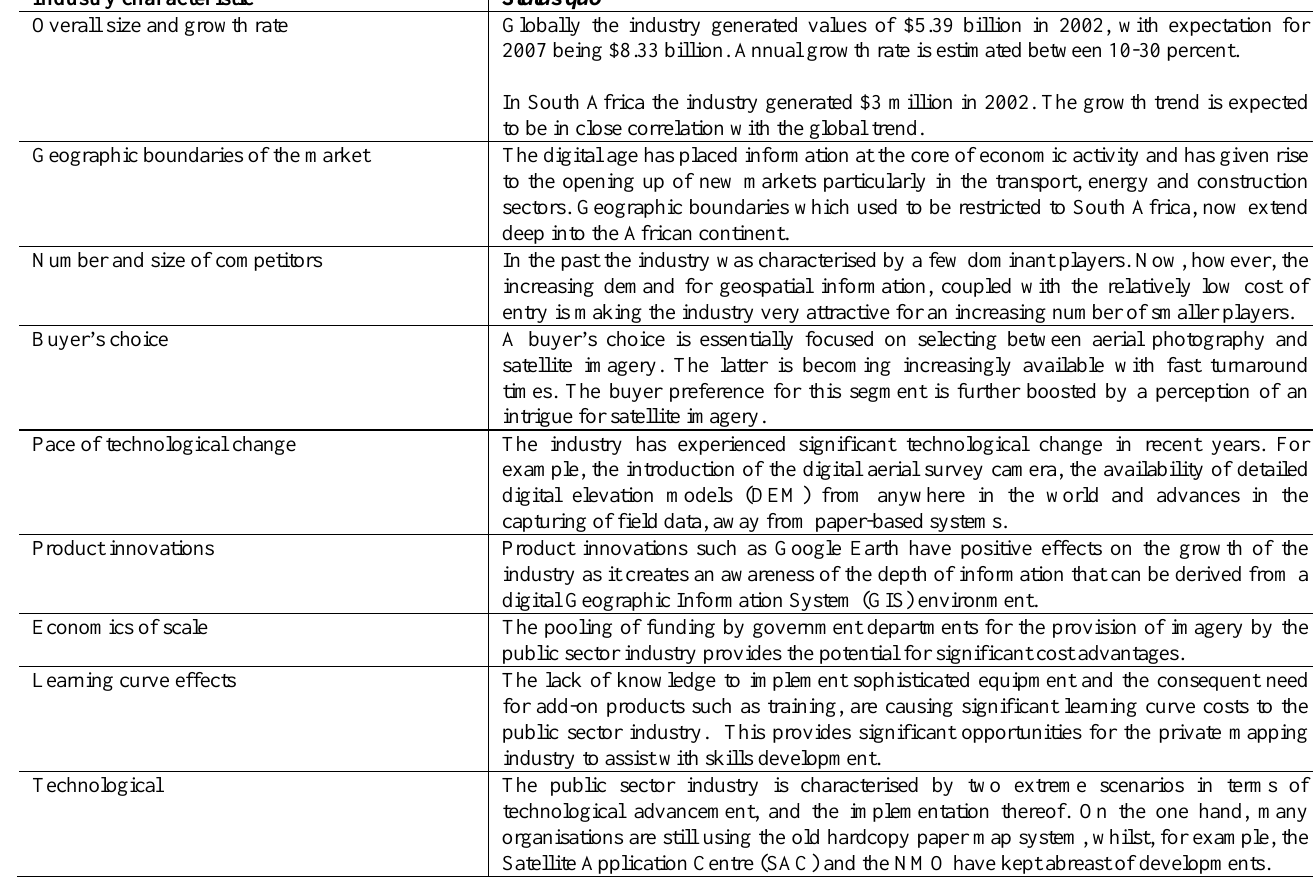
Table 1: Profile of geospatial information